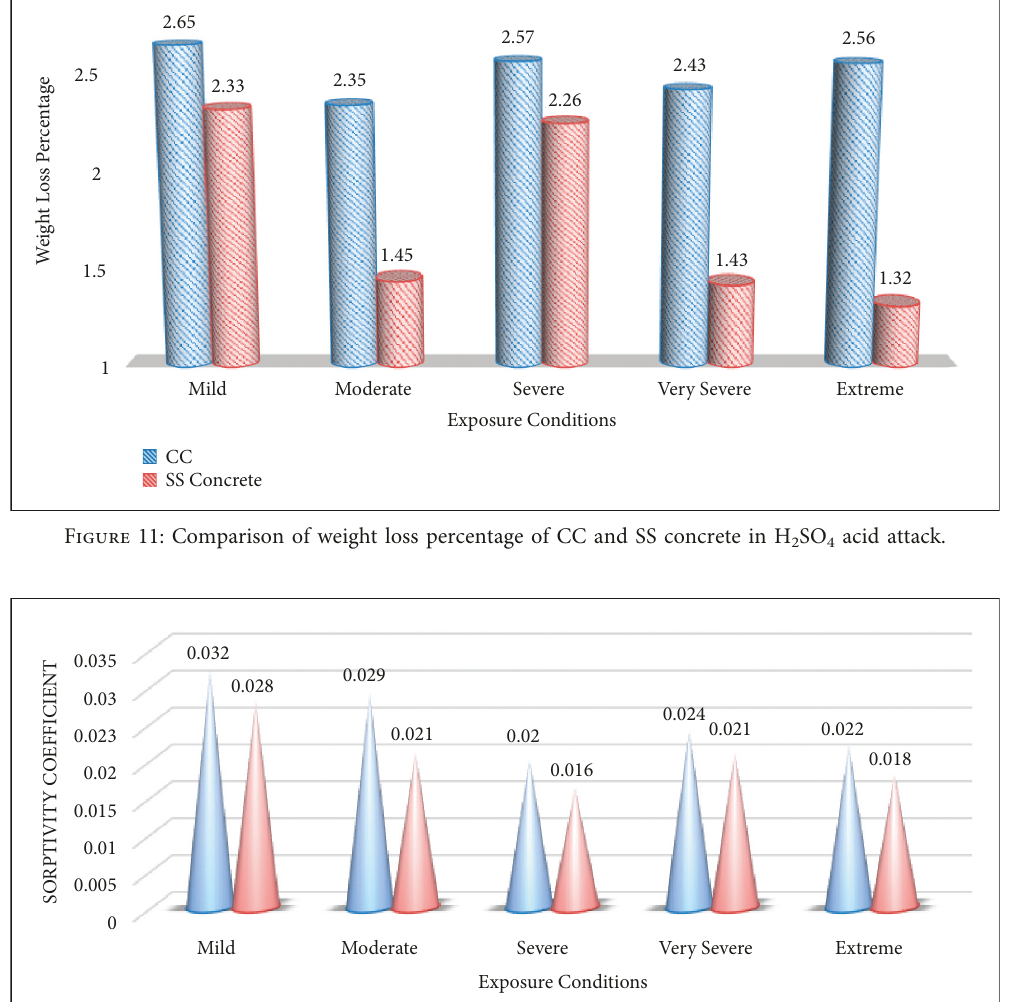
Figure 12: Sorptivity coefficient for CC and SS concrete.